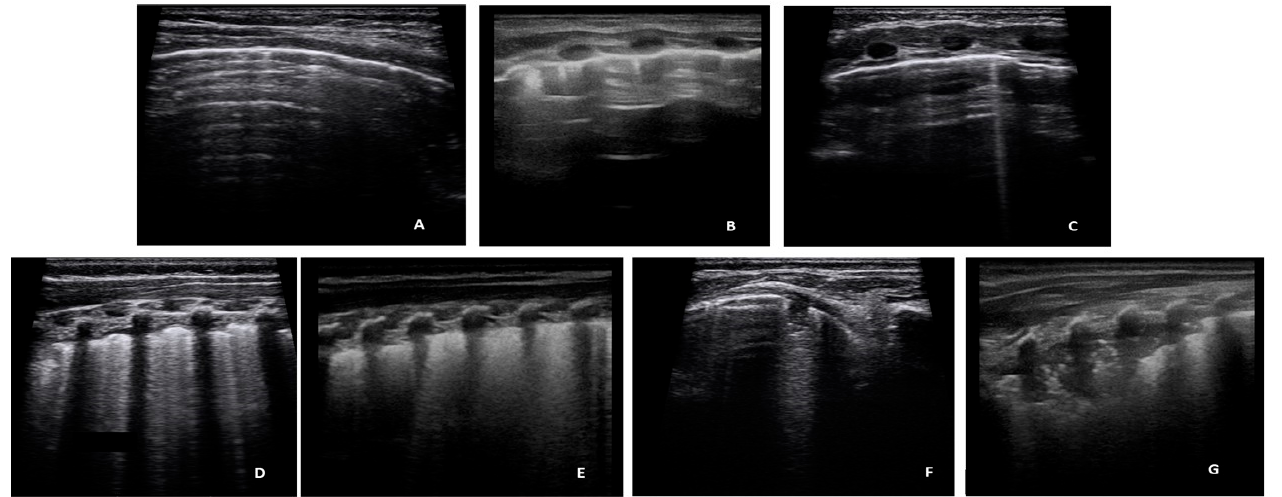
Figure 2. Images of the seven types of artifacts. ( A ) A-lines; ( B ) Short Vertical Artifacts; ( C ) Isolated B Lines; ( D ) Confluent B-Lines; ( E ) White Lung; ( F ) Sub-pleural consolidation ≤ 1 cm; ( G ) Sub-pleural consolidation > 1 cm.